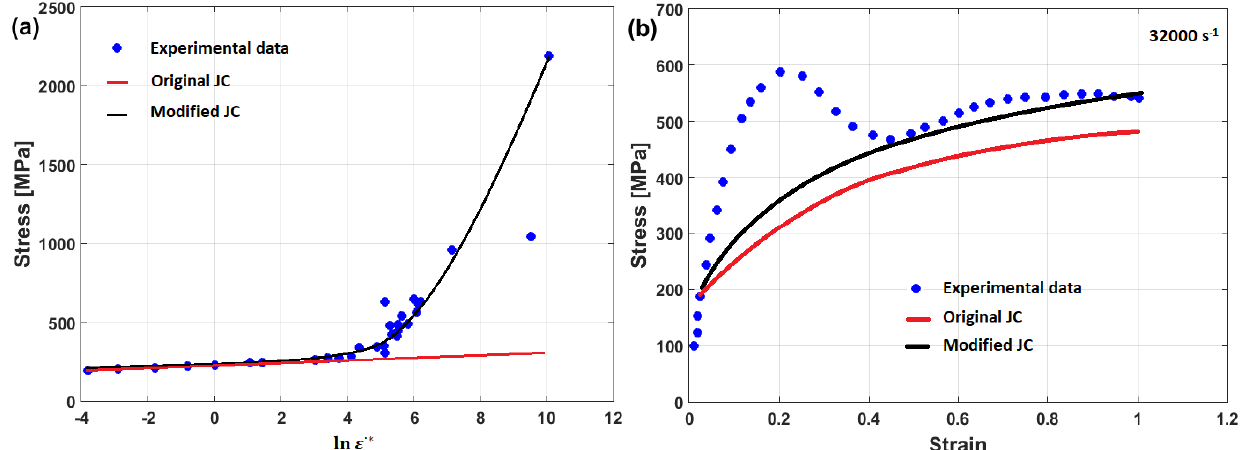
Figure 44. Comparison of experimental stresses (markers) and predicted stresses (solid lines) by using the JC model and the modified JC model that was presented by Chakrabarty et al. [91]: ( a ) stress vs. logarithmic strain rate and ( b ) stress vs. strain.